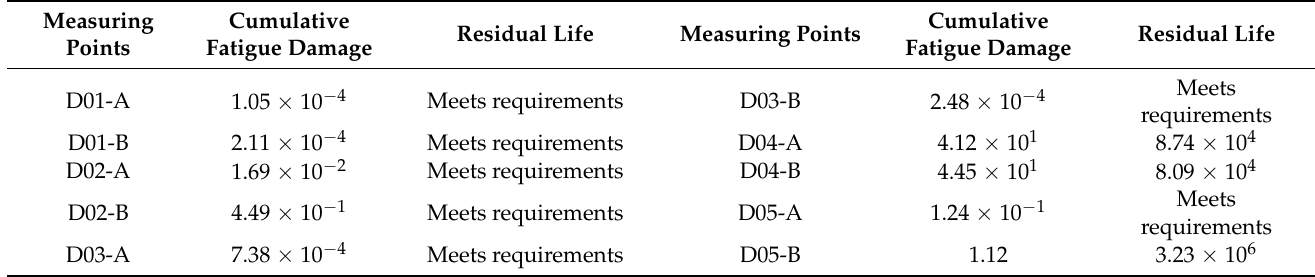
Table 2. Cumulative fatigue damage and residual life.